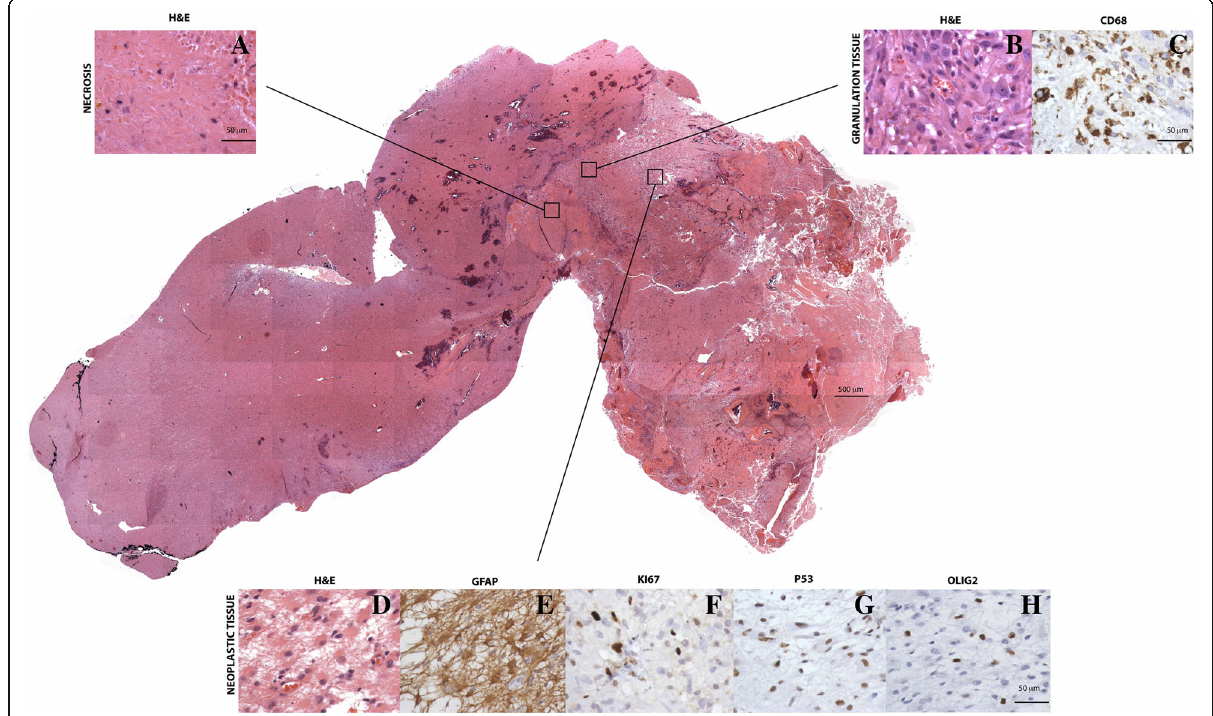
Fig. 3 Histologic analysis of laser-induced thermal therapy treated left temporal glioblastoma multiforme revealed distinct histologic zones. Hematoxylin and eosin stained sections represent neoplastic tissue surrounded by granulation tissue and necrosis. Section images were captured (original magnification 4X) and collaged. Higher-magnification of a necrotic area (Zone 1), b granulation tissue (Zone 2) and d tumor (Zone 3). c Macrophages detected by CD68 immunohistochemistry in granulation tissue. e Glial fibrillary acidic protein stained astrocytes ( f , g and h ). Single cells with positivity for f Ki67, g p53 and h Olig2 consistent with viable